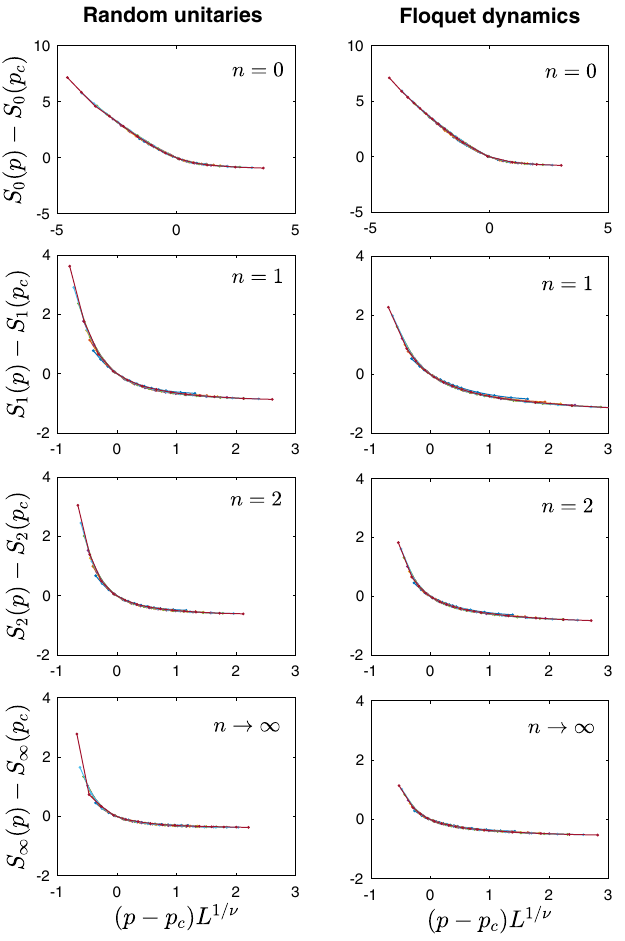
FIG. 14. Critical scaling for the bipartite entanglement S measured by numerical simulations of the random unitary circuit (left column of plots) and the Floquet dynamics (right column). Each plot is labeled by the corresponding value of n and shows curves for seven different system sizes, ranging from L ¼ 6 to L ¼ 24 [the same as in the legend of Fig. 13(a)]. The simulation time was t ¼ 2 L for the simulations of random unitaries and t ¼ 8 L for the Floquet dynamics. The corresponding values of p ν for each plot are listed in Table I.